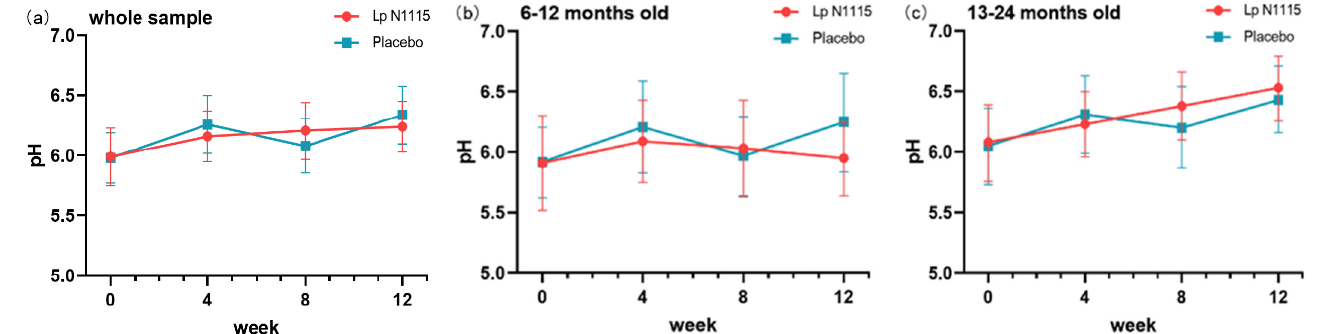
Figure 2. Fecal pH changes throughout the intervention. ( a ) Fecal pH changes of all participants; ( b ) Fecal pH changes of 6–12-month-old subgroup; ( c ) Fecal pH changes of 13–24-month-old sub- group.